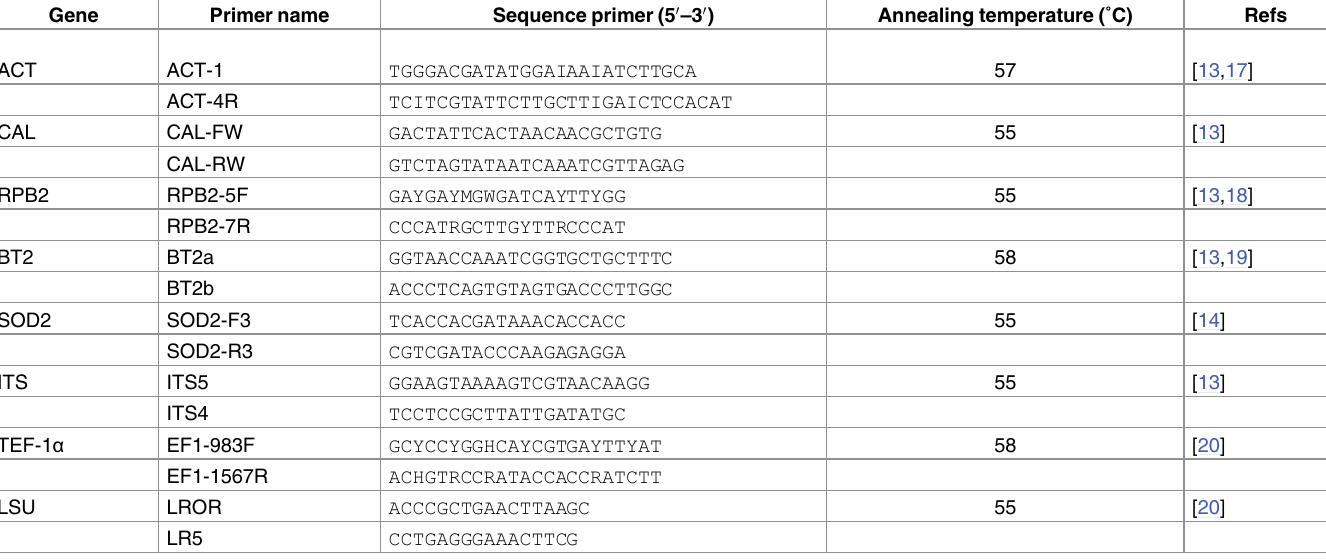
sequence was trimmed to the correct length with the start and the end of each gene (shown in Table 3). Genotype variation of each gene was analyzed by MLSTest v1.0.1.23 software, which was downloaded from http://ipe.unsa.edu.ar/software [21]. The ATs number was created by Table 2. List of primers used in the present